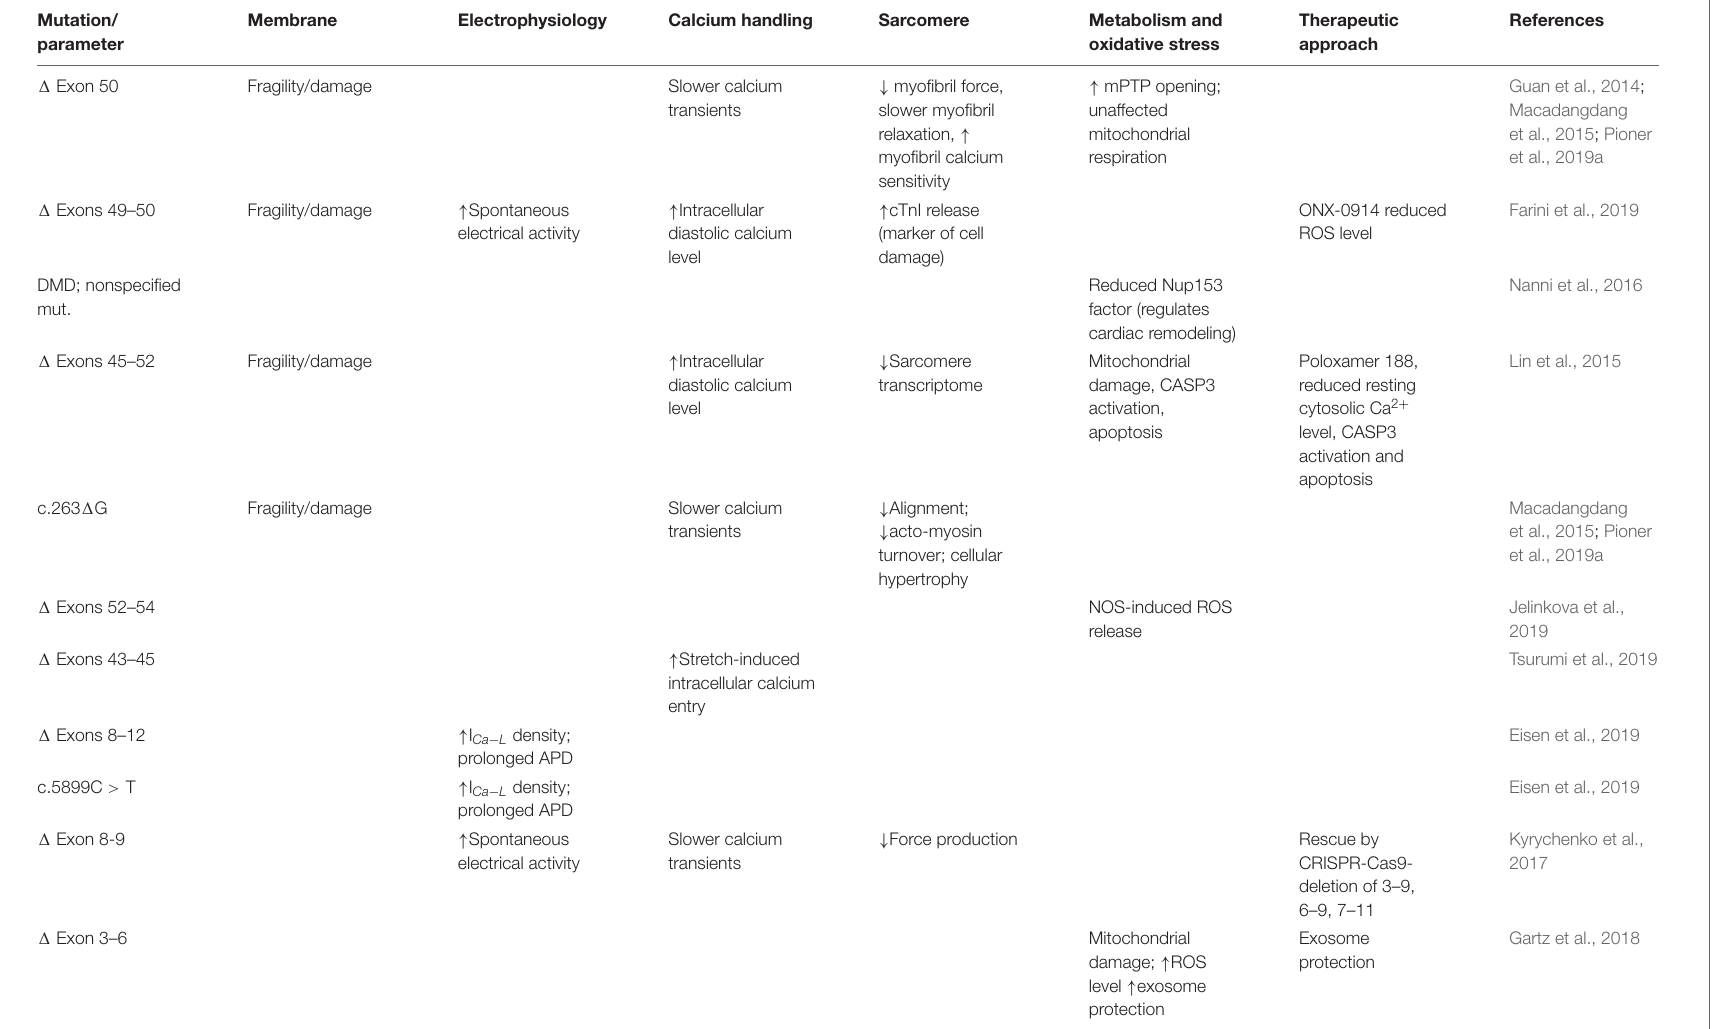
TABLE 2 | DMD-cardiomyopathy studies based on hiPSC-CMs: individual mutations vs. functional parameter and therapeutic attempts in vitro